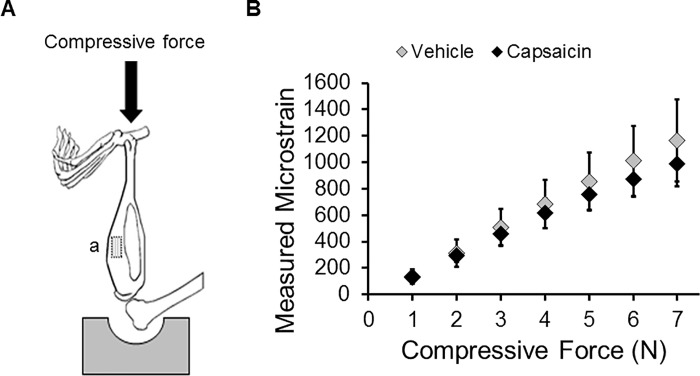
Maximum bone strain during tibial compression at the anteromedial tibial surface.(A) A diagrammatic representation shows the approximate location of the strain gauge (a). (B) Maximum bone strain measured during tibial compression at compressive magnitudes from 1–7 N. No significant differences in measured strain were observed between capsaicin- and vehicle-treated mice at any of the compressive forces tested.